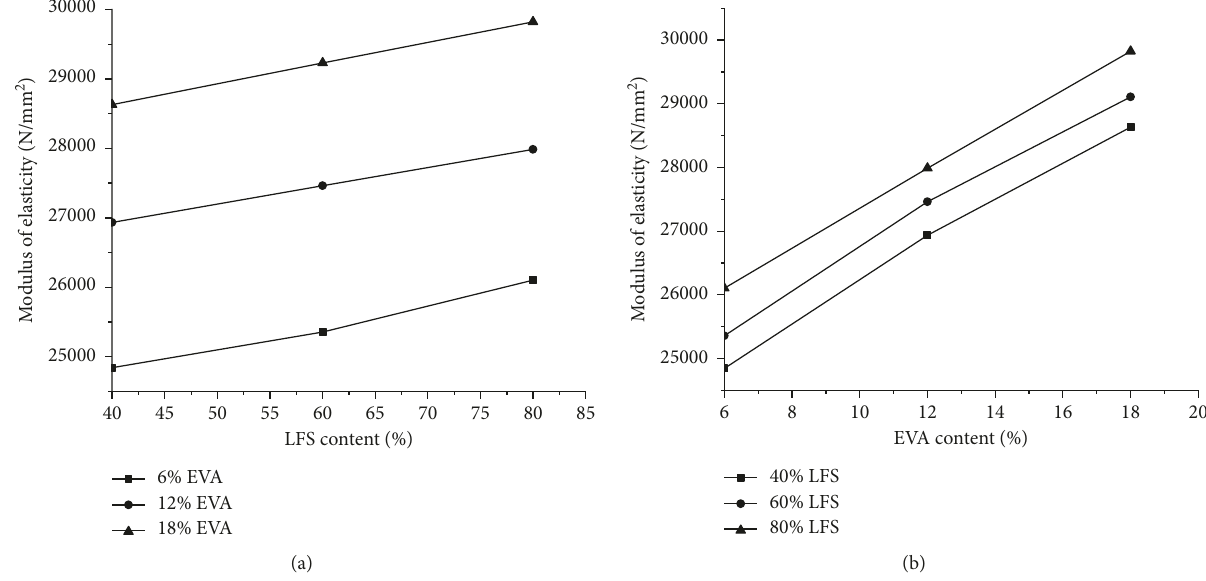
Figure 8: Comparative analysis of elastic modulus at a fixed rate of (a) EVA inclusion and (b) LFS